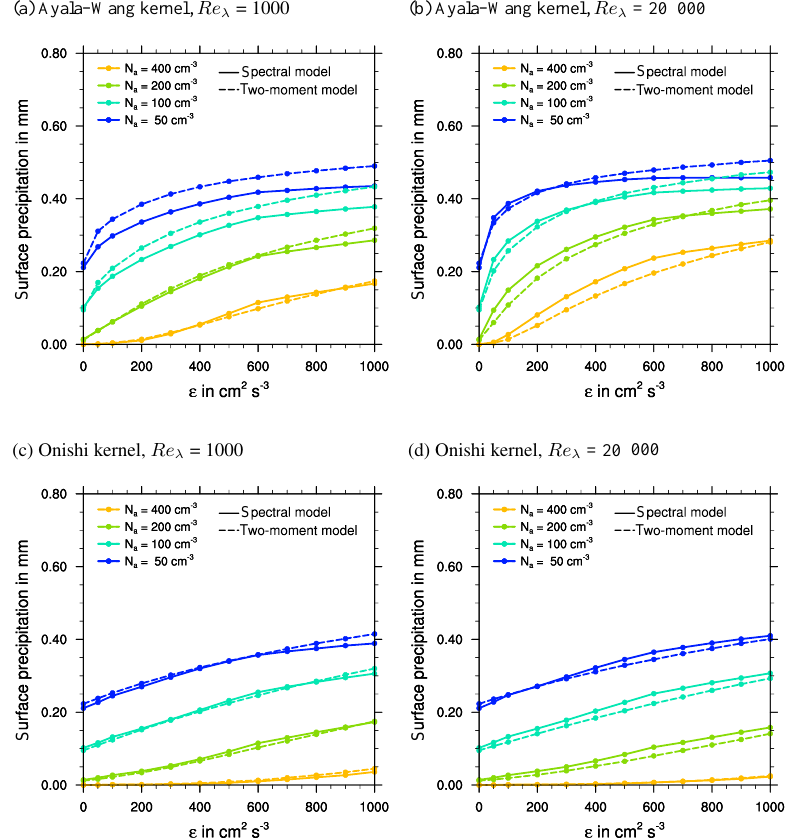
Figure 4. Accumulated surface precipitation of the 1-D kinematic model as a function of the assumed in-cloud turbulent dissipation rate (cid:15) (other parameters are temperature gradient (cid:48) 0 = 1 . 5Kkm − 1 , the maximum updraft speed w 0 = 2ms − 1 , and the updraft timescale τ w = 40min). Shown are results from the Ayala–Wang model at Re λ = 1000 (a) and Re λ = 20000 (b) , as well as the Onishi model at those two Reynolds numbers (c, d) . Results of the spectral bin reference model are depicted with solid lines, and the results of the two-moment parameterization with dashed